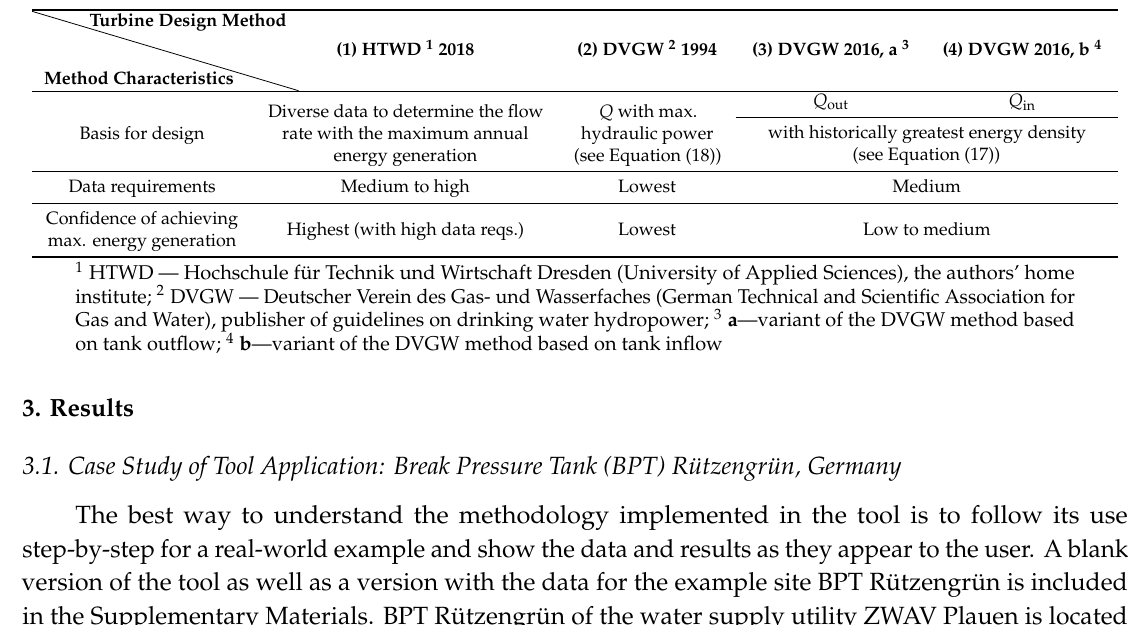
Table 3. Summary of turbine design methods from the authors’